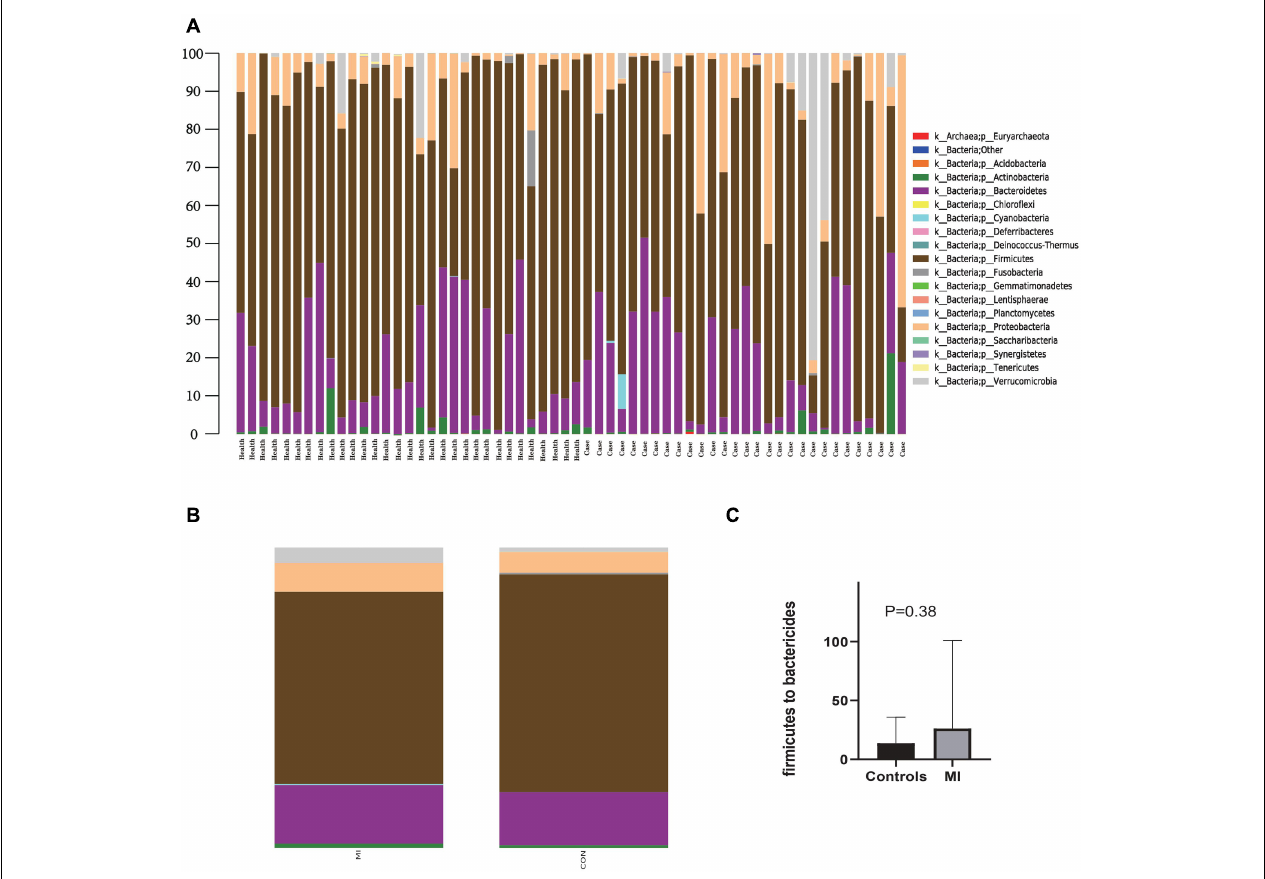
FIGURE 1 | The distribution of relative abundance of top 20 at the phylum level. (A) Shows the distribution of relative abundance of top 20 in each fecal sample. (B) Shows the distribution of relative abundance of top 20 in AMI group and the healthy control group. MI, AMI group; CON, the healthy control group. (C) Shows the Firmicutes to Bactericides ratio in AMI group and the healthy control